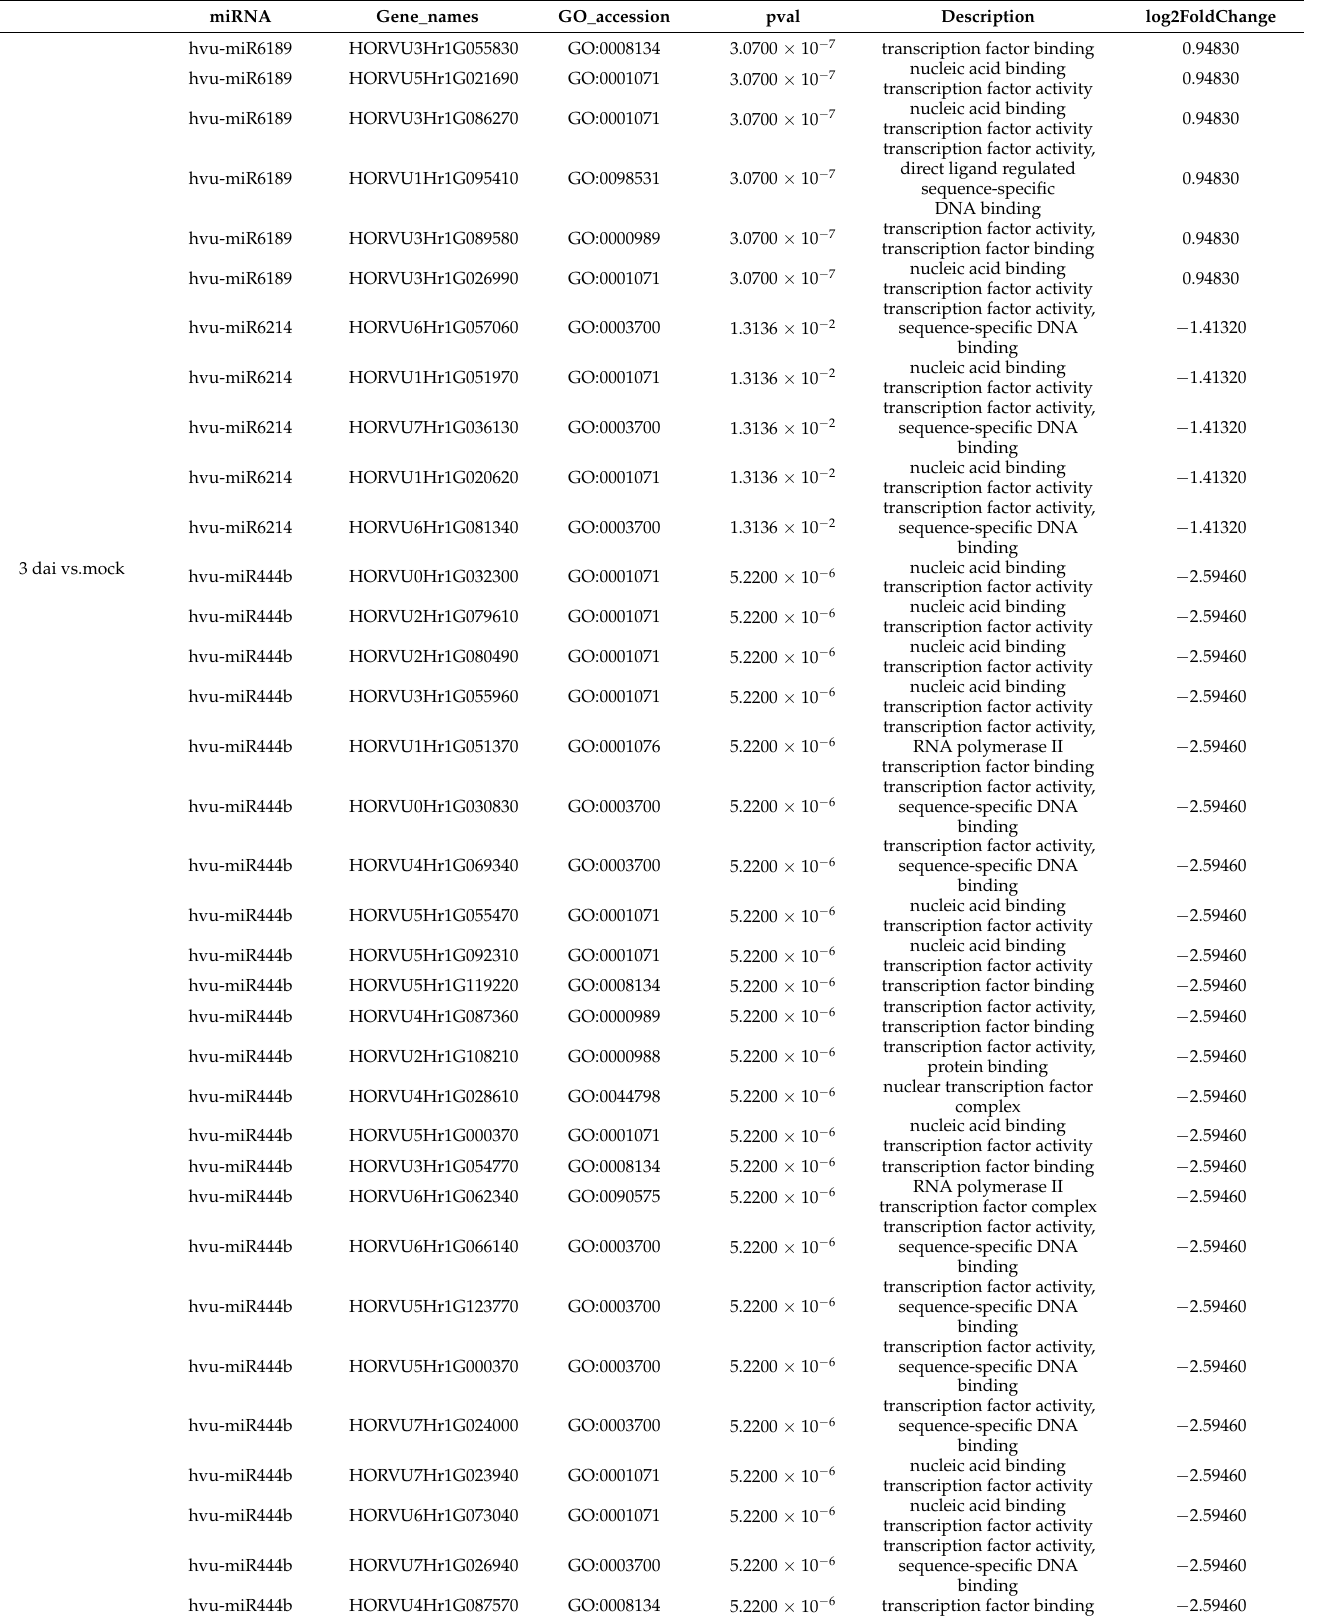
Table 6. Several key miRNAs targets involved in the regulation of gene